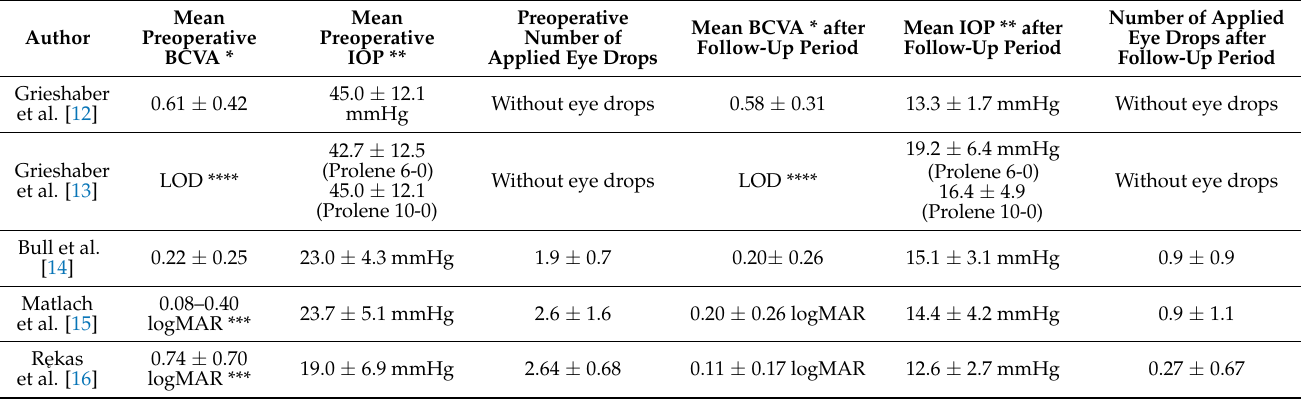
Table 2. Mean pre- and postoperative values of best corrected visual acuity, intraocular pressure, and number of antiglau- coma medications used before and after